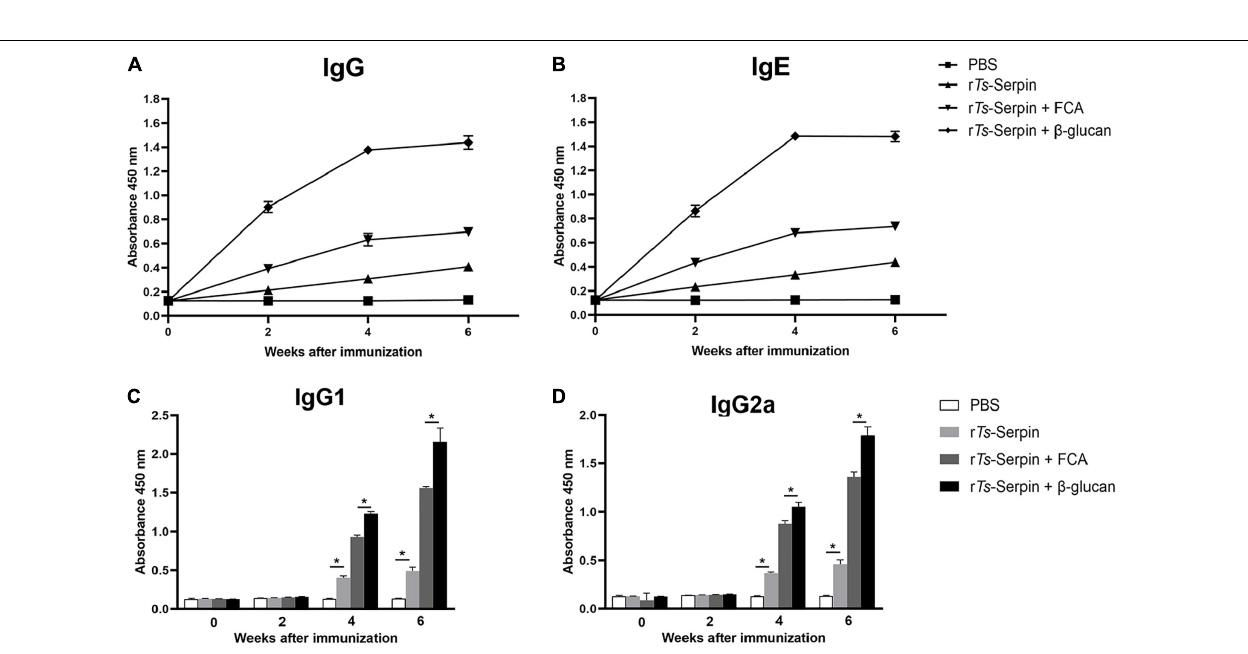
FIGURE 2 | Analysis of humoral immune responses. (A) The levels of IgG in the serum were measured by ELISA. (B) The levels of IgE in the serum were measured by ELISA. (C) The levels of IgG1 in the serum were measured by ELISA at different time points. (D) The levels of IgG2a in the serum were measured by ELISA at different time points. The values shown for each group are the mean + SD of the antibody levels ( n = 10) from three individual experiments * P < 0.05 as indicated by the line (one-way ANOVA with Tukey’s post-test).